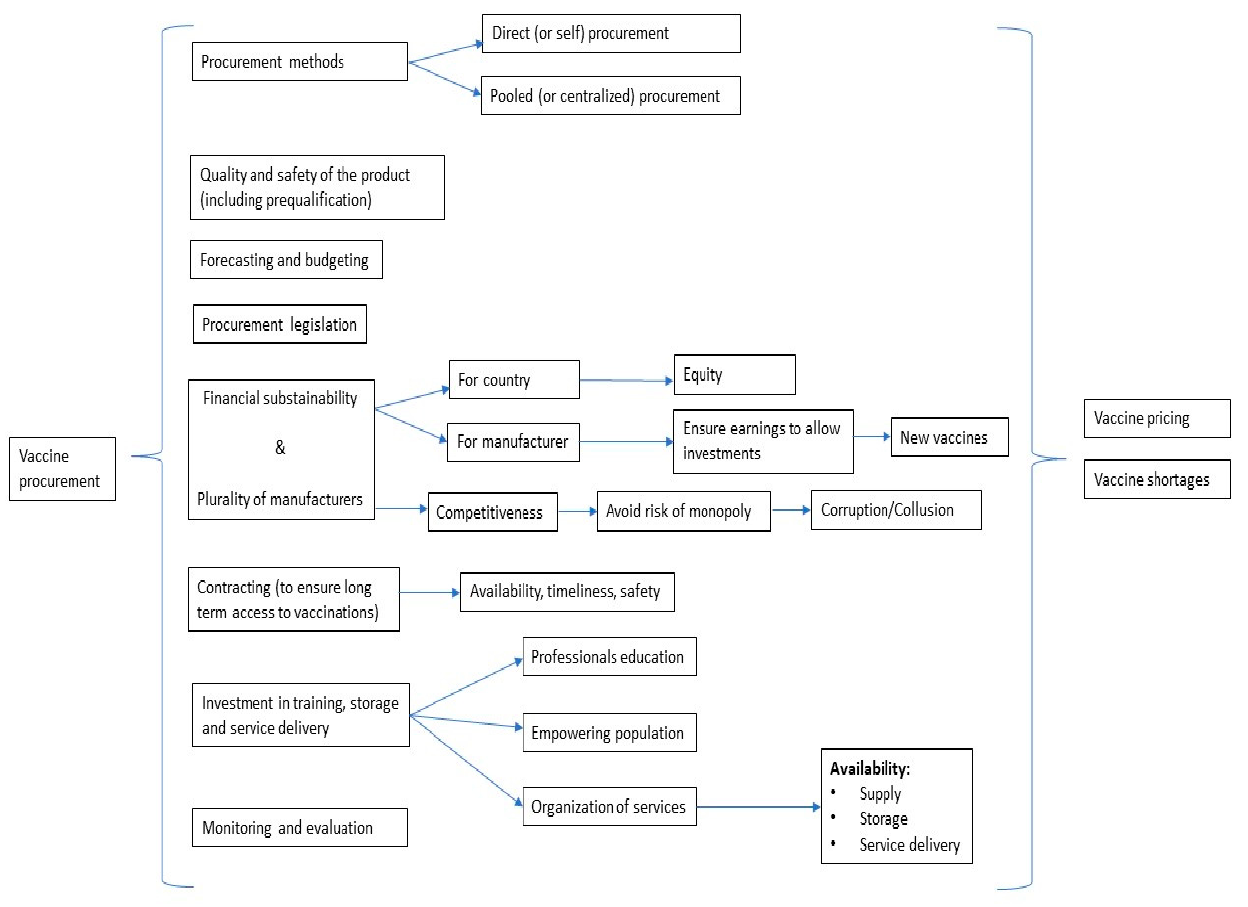
Figure 1. Flow diagram of the selection process.